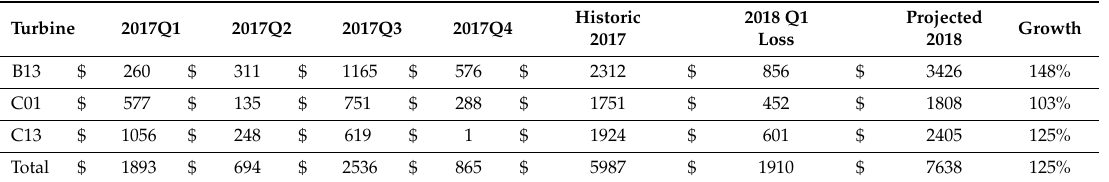
Table 5. Economic losses 2017 / 18 for the selected wind